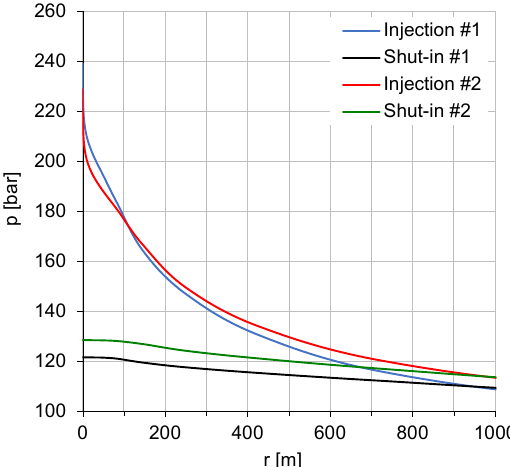
Figure 9. Pressure profiles at end of injection and shut-in periods for the run in Figure 8.